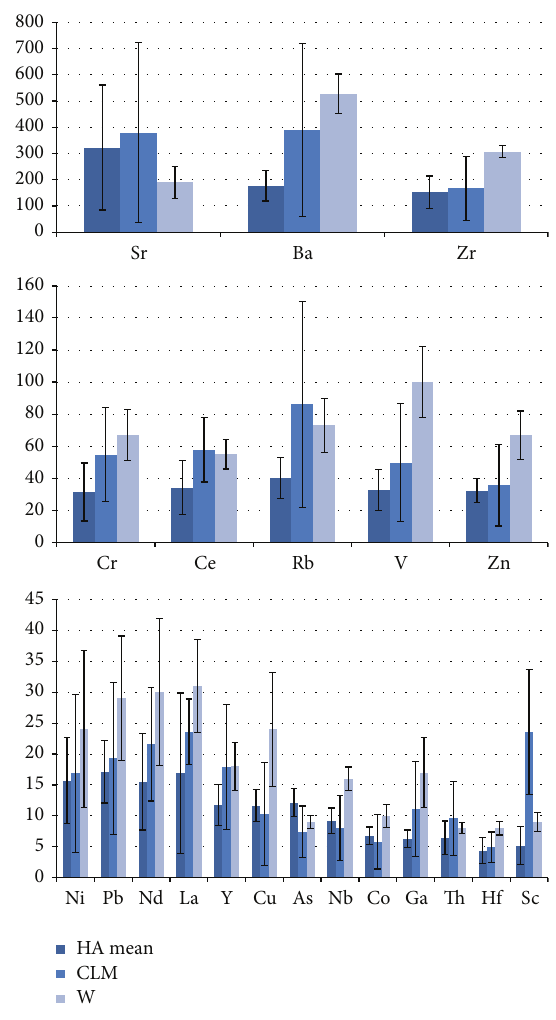
Figure 3: Representation of trace element contents (mg/kg) in surface horizons (HA) of the studied soils ( 𝑛 = 5 ) related to Castilla- La Mancha (CLM, [22]) and World (W, [17]) contents. Error bars show Standard